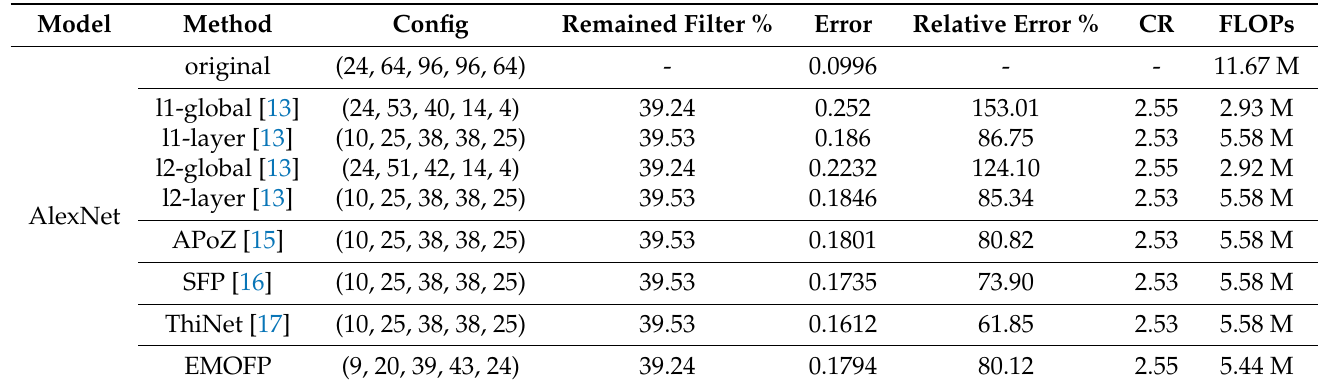
Table 8. Comparison of the pruning results of AlexNet on